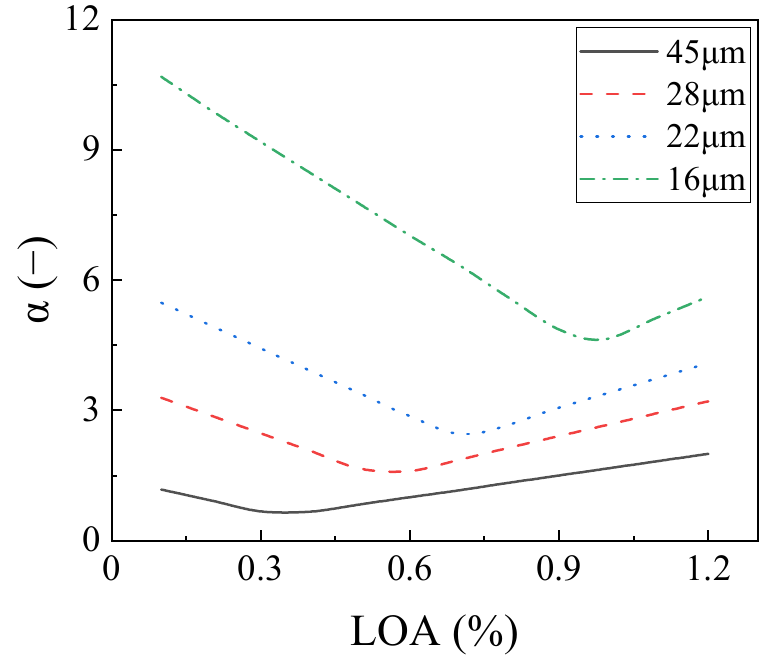
Figure 13. Dimensionless force between particles vs. LOA for different host particle size ( η = 0.1).